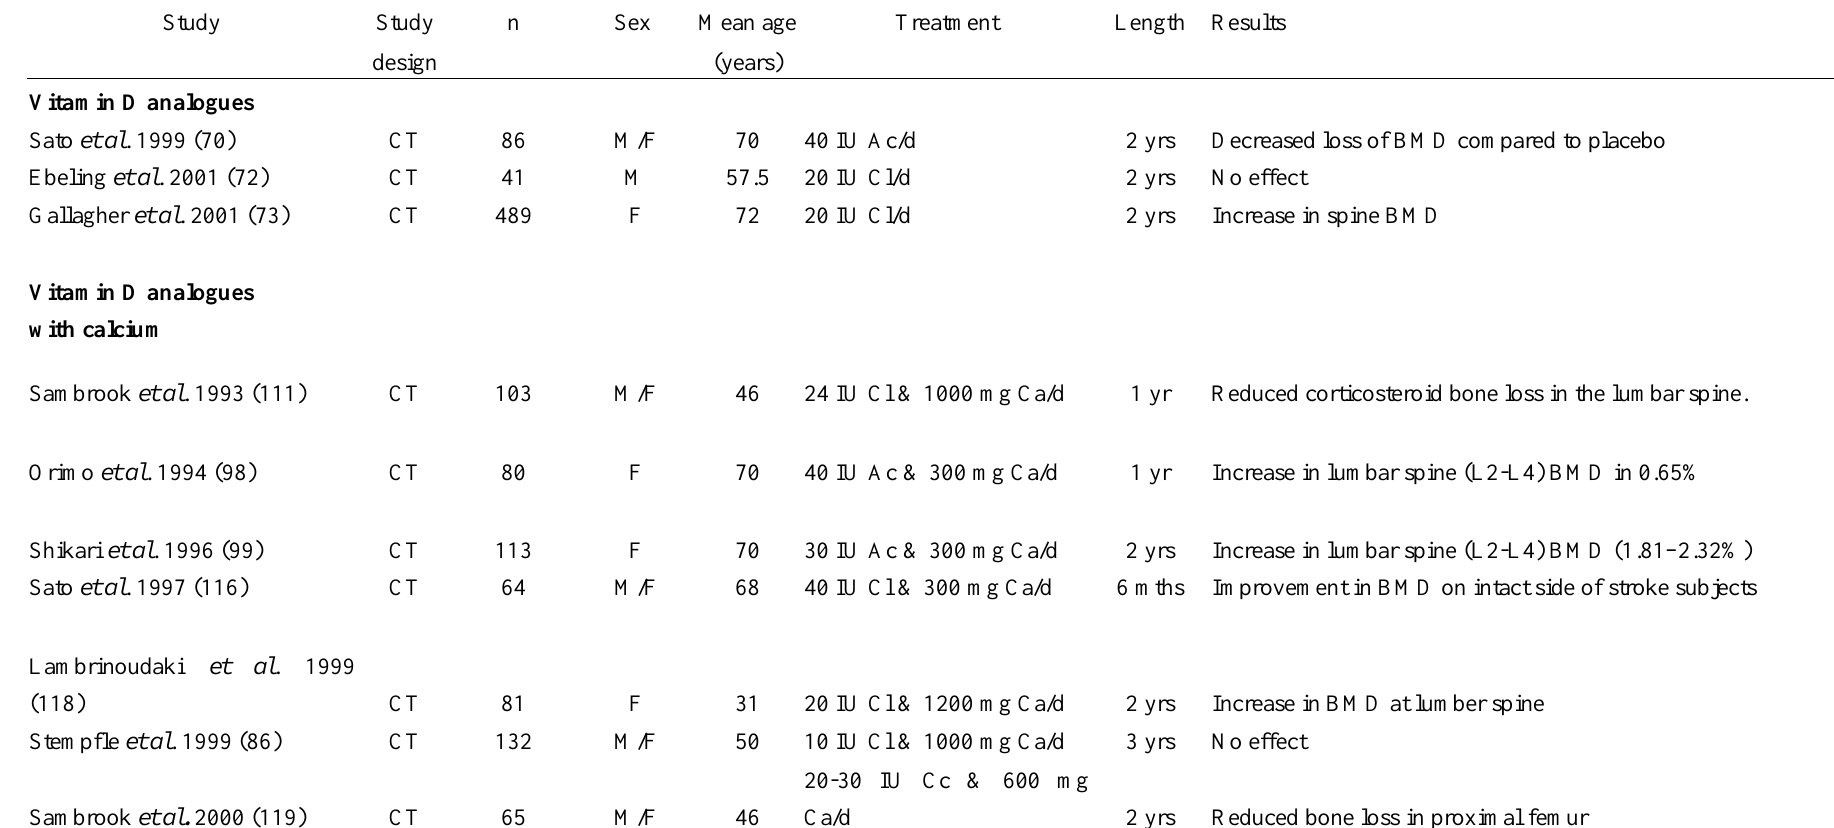
Table 5. Intervention with vitamin D analogues (with / without calcium) on